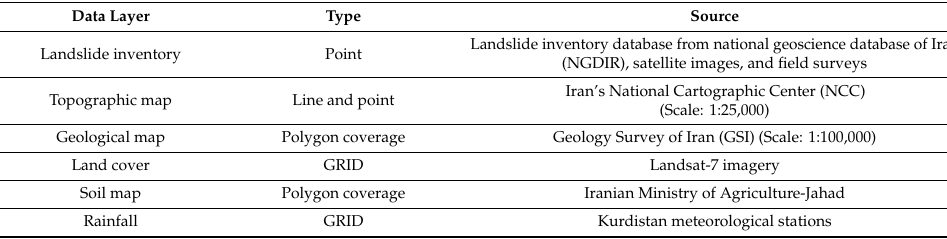
Figure 1. The location of the study area and the marked landslide incidents. Table 1. List and source of the spatial database.